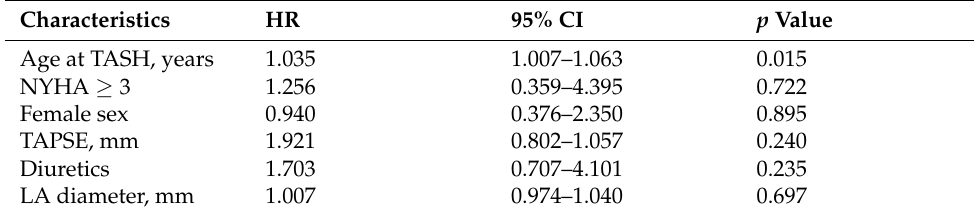
Table 4. Multivariate Cox regression